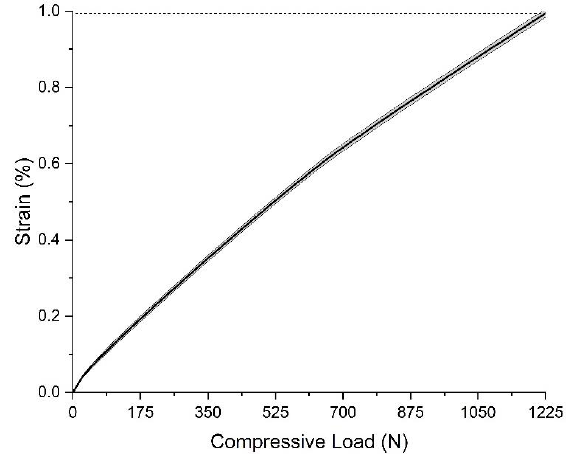
Figure 12. Strain of 4R23 adaptor under the transverse compressive load.